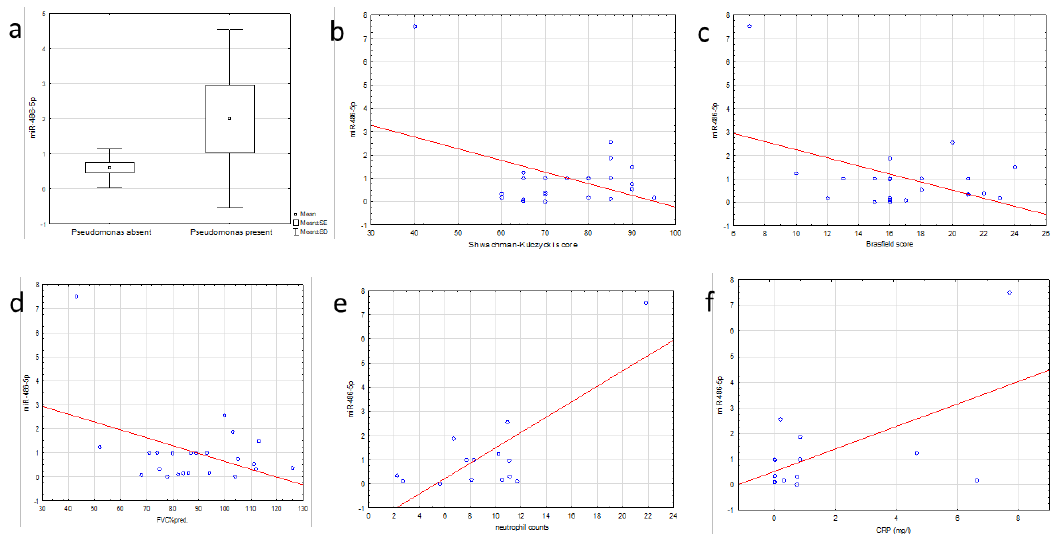
Figure 5. Association of miR-486-5p expression in sputum and clinical parameters in CF patients ( a ) in relation to Pseudomonas infection ( p = 0.044, 1-way analysis of variance); ( b ) correlation with Shwachman – Kulczycki score ( r = − 0.42, p = 0.048), ( c ) correlation with Brasfield score ( r = − 0.45, p = 0.031); ( d ) Spearman correlation with FVC (r = − 0.451, p = 0.045); correlation with